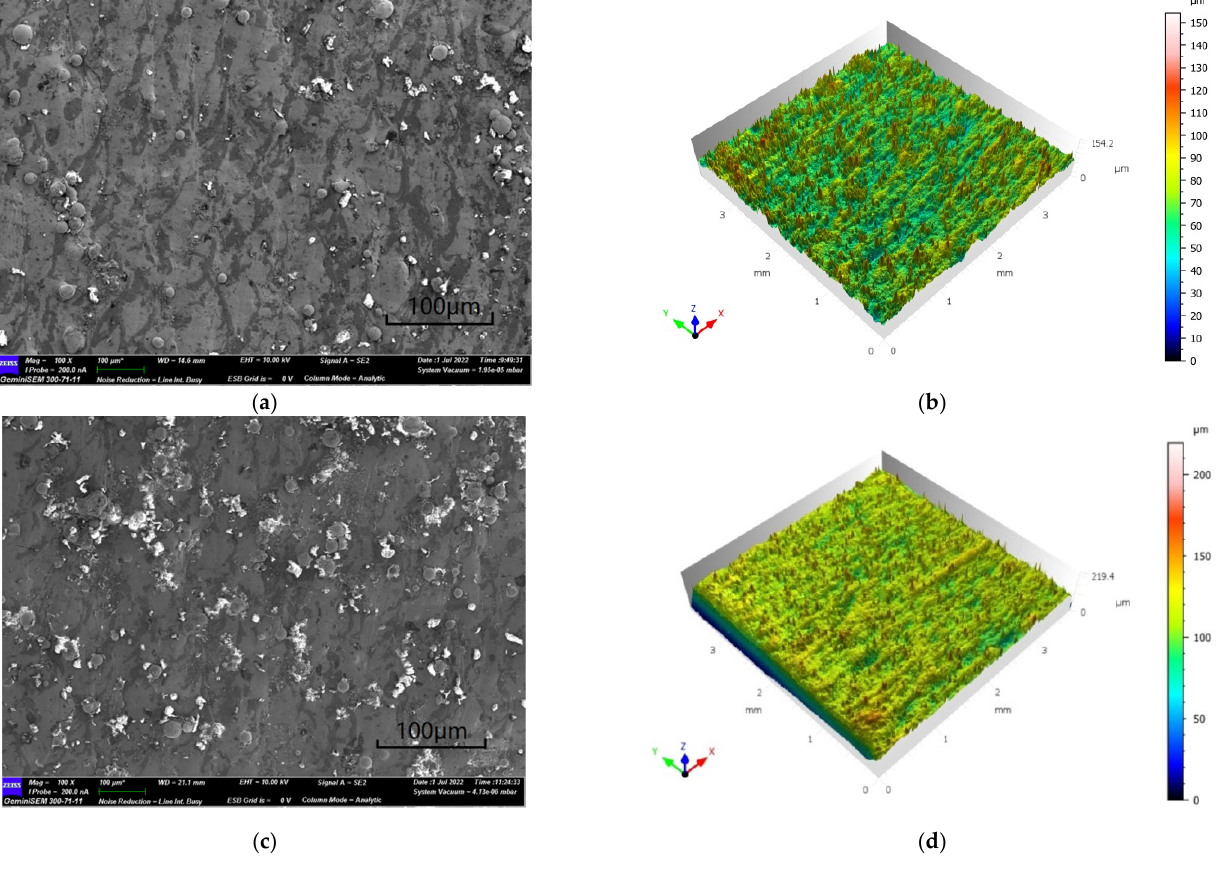
Figure 7. SEM images and 3D profiles of Part A’: ( a , b ) horizontal plane; ( c , d ) vertical surface.